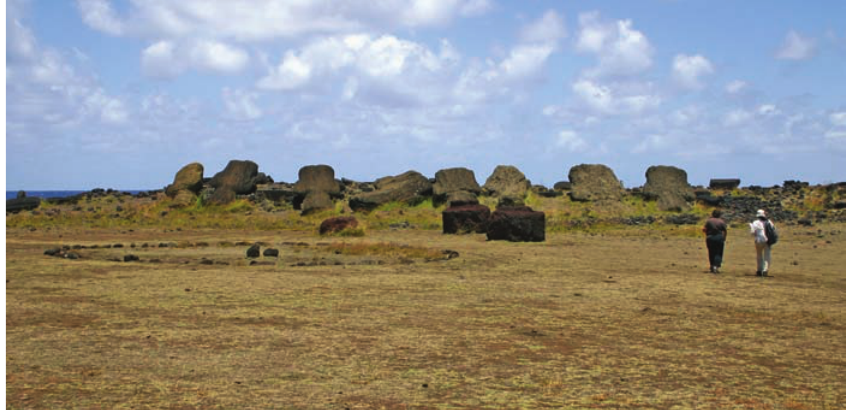
Figure 9 Ahu Hanga Tee (Vaihu), one of our sites of detailed landscapes studies. Note the stone-free, levelled plaza in front of the ahu and fallen statues.